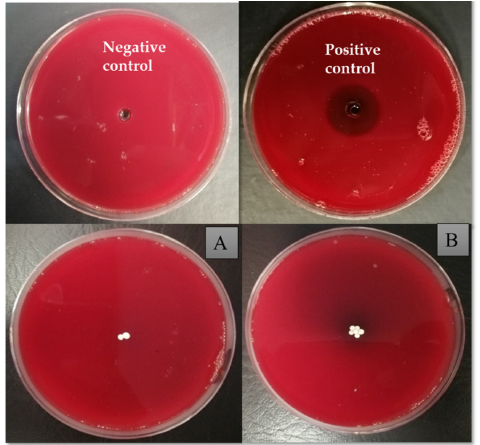
Figure 14. Hemolytic activity analysis on blood agar plates with DMSO (negative control) and Triton X (positive control). CI-TiO 2 -MS: ( A ) 2 g, and ( B ) 6 g.